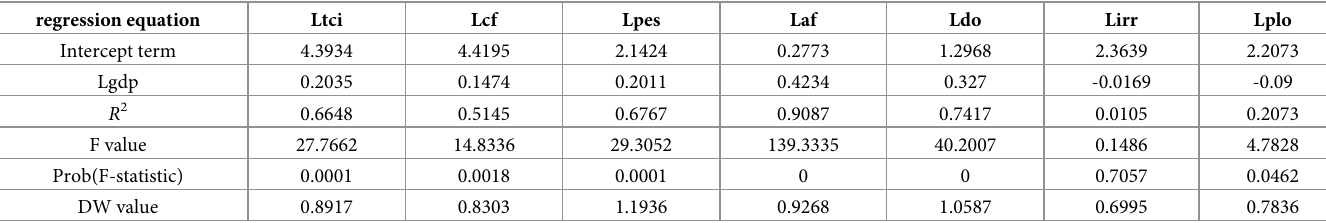
Table 5. Logarithmic linear regression of agricultural carbon emission intensity and economic growth. regression